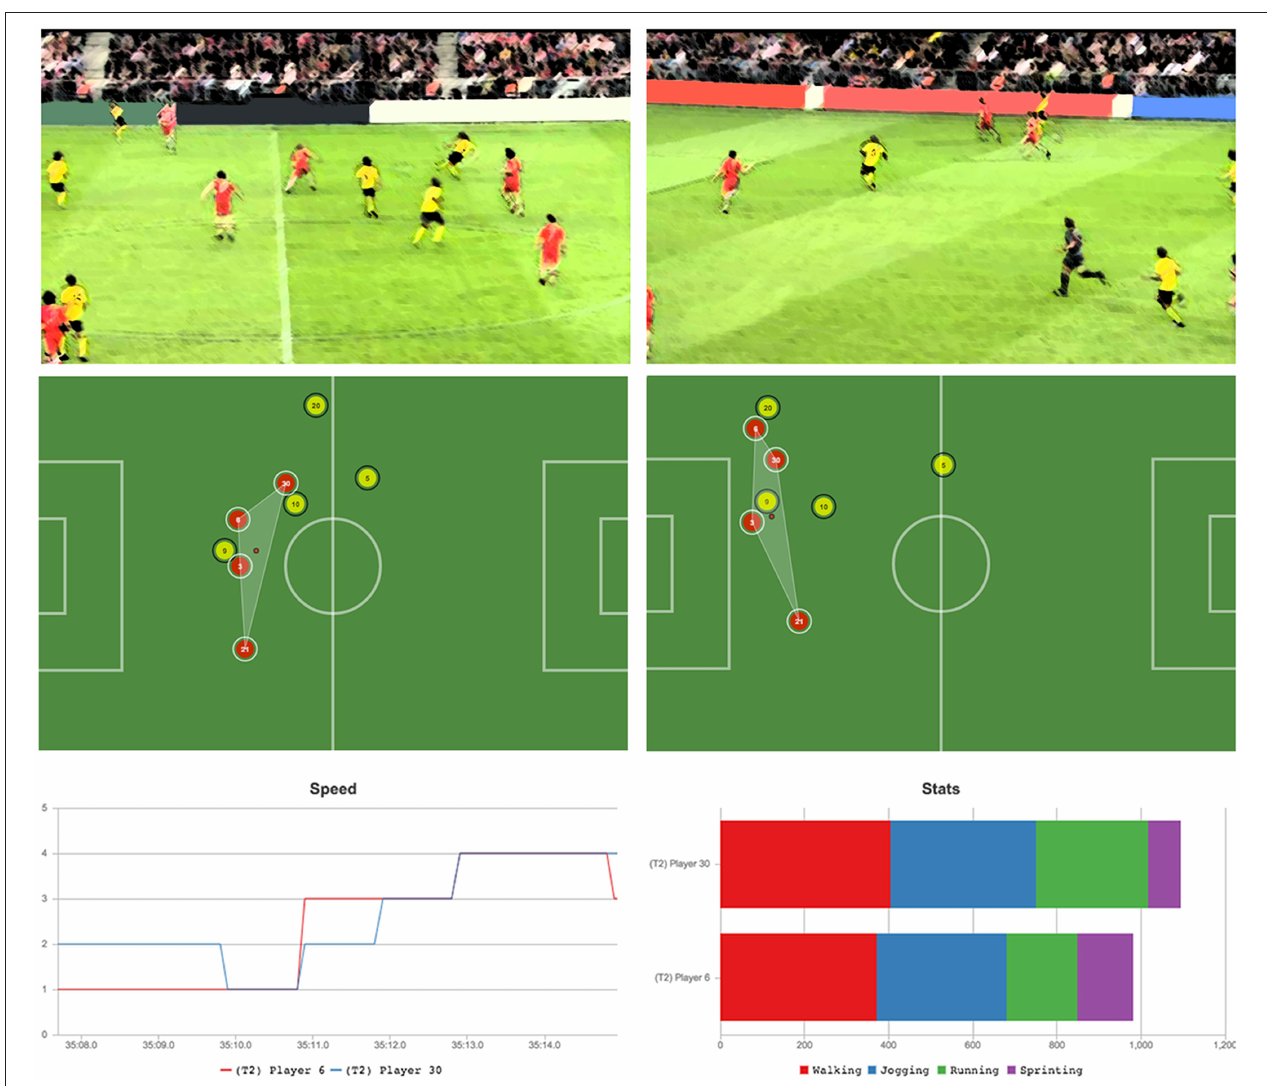
FIGURE 8 | Top: Second moment of low coordination between two defenders (players 3 and 6, red). Bad defending from another player causes the disruption. Bottom: Speed and movement comparison between the two defenders involved in the opposition advantage play.